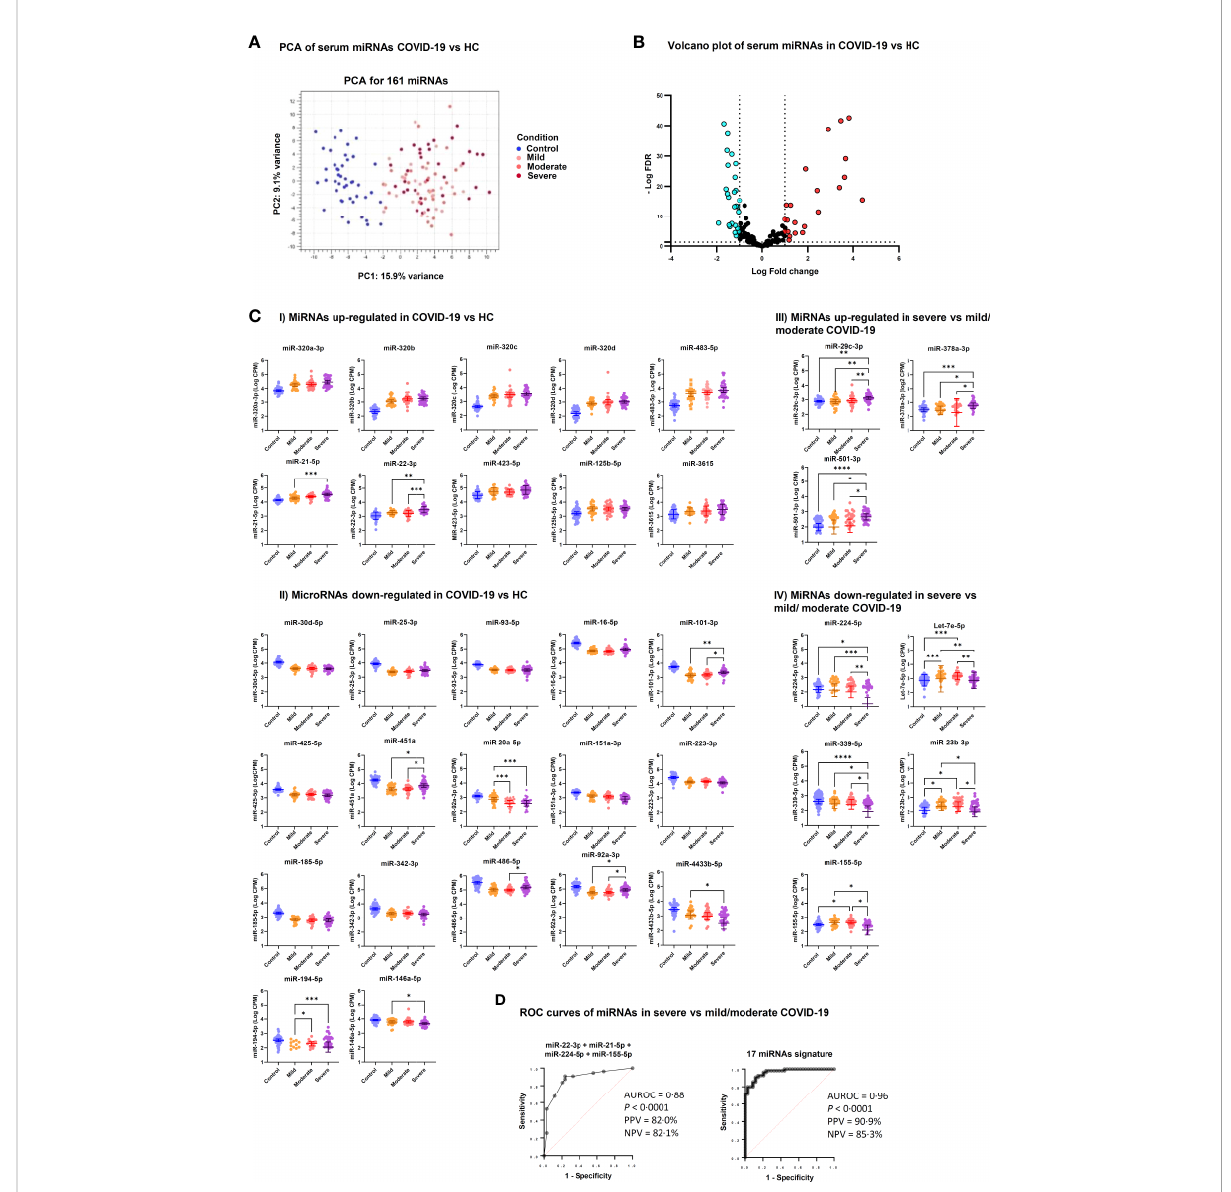
FIGURE 1 Differentially expressed serum miRNAs in COVID-19 patients. (A) Unsupervised principal component analysis of miRNA expression pro fi les in COVID-19 and HC samples (phenotype); condition is red for HC and blue, green, violet for COVID-19 severity. (B) Volcano plot of 161 miRNAs analyzed for differential expression (DE); vertical lines delineate > ± 2-fold change; horizontal line delineate adjusted p < 0.05. Adjusted p-values using Generalized Linear Model and trimmed mean of M-values normalized counts were used as input data and adjusted for multiple testing using the Benjamini – Hochberg false discovery rate (FDR) method; light blue dots indicate downregulated miRNA and red dots upregulated miRNAs . (C) Scatter dot plots of candidate DE serum miRNAs in COVID-19 patients. MicroRNA expression is reported as Log 10 counts per million reads (Log CPM). Panels I and II show miRNAs that were up- and downregulated in severe, moderate and mild COVID-19 vs. HC, while Panels III and IV show DE miRNAs in severe COVID-19 vs. moderate and mild disease. Geometric mean values with 95% con fi dence interval (95% CI) are indicated by lines and error bars. Pairwise comparison between groups was done by Kruskal Wallis test for multiple comparisons, considering Benjamini-Hochberg adjusted p-values ≤ 0.05. Groups include healthy controls (Control, n = 45), mild COVID-19 (Mild, n = 26), moderate COVID-19 (Moderate, n = 29), and severe COVID-19 (Severe, n = 34). ****p<0.0001, ***p<0.001, **p<0.01, *p<0.05. Since Panels I and II include miRNAs that were DE in all COVID-19 groups (mild, moderate and severe) vs. HC, statistical signi fi cance is indicated only for comparisons among COVID-19 groups . (D) Candidate miRNA biomarkers to classify severe COVID-19 vs. mild/moderate COVID-19. P values and receiver operating characteristic (ROC) curves were calculated by multiple logistic regression analysis. AUROC, area under the ROC curve; PPV, positive predictive power; NPV, negative predictive